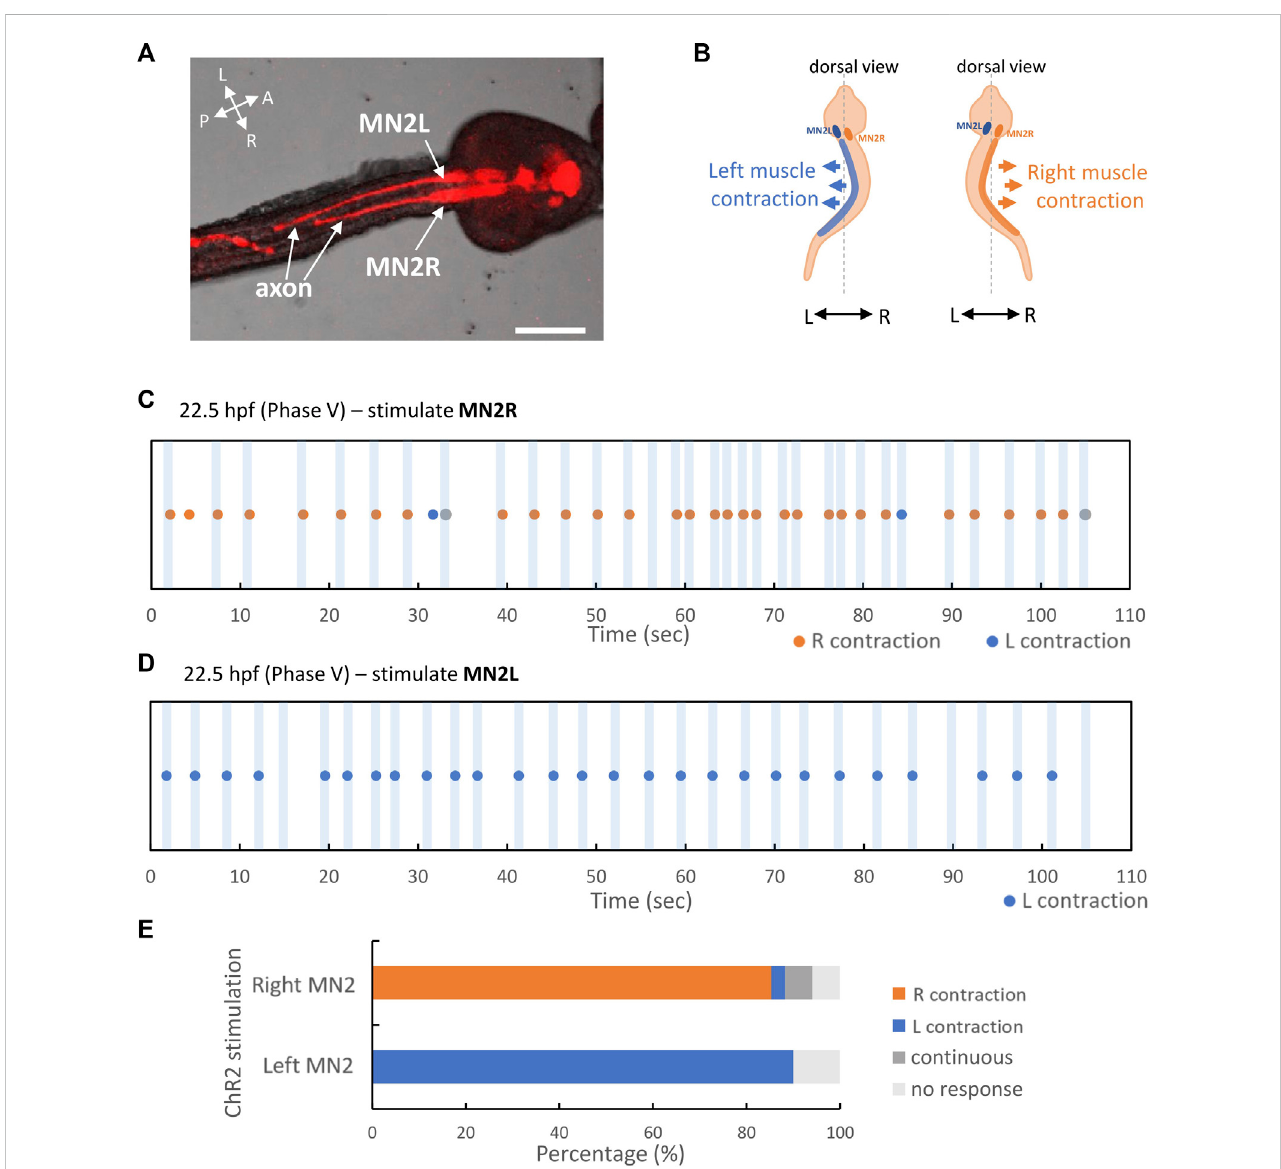
photostimulatedandimagedbyCLSM.Larvawas fi xedonthedorsalside.MN2LandMN2Rwereirradiatedindependently.Orangedotsindicatethetimepoint whenrighttailmusclecontracted,bluedotsindicatethetimepointwhenlefttailmusclecontracted,andgraydotsindicatethetimepointwhentail fl ickedleft andrightcontinuously(swimmingbehavior).SeealsoSupplementaryVideoS3. (A) Stackedconfocalimageofthestimulatedlarva.Imagesweretakenby CLSM (DIC + fl uorescentimageswith 594 nm excitation). Scale bar 50 µm. (B) Schematic illustrationof right muscle contraction and left muscle